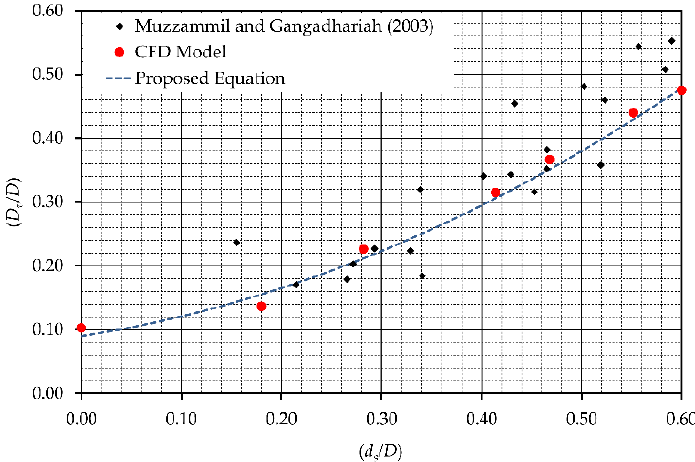
Figure 18. Comparing the development of the HV vortex mean size during the development of the scour hole with experimental data of [49].